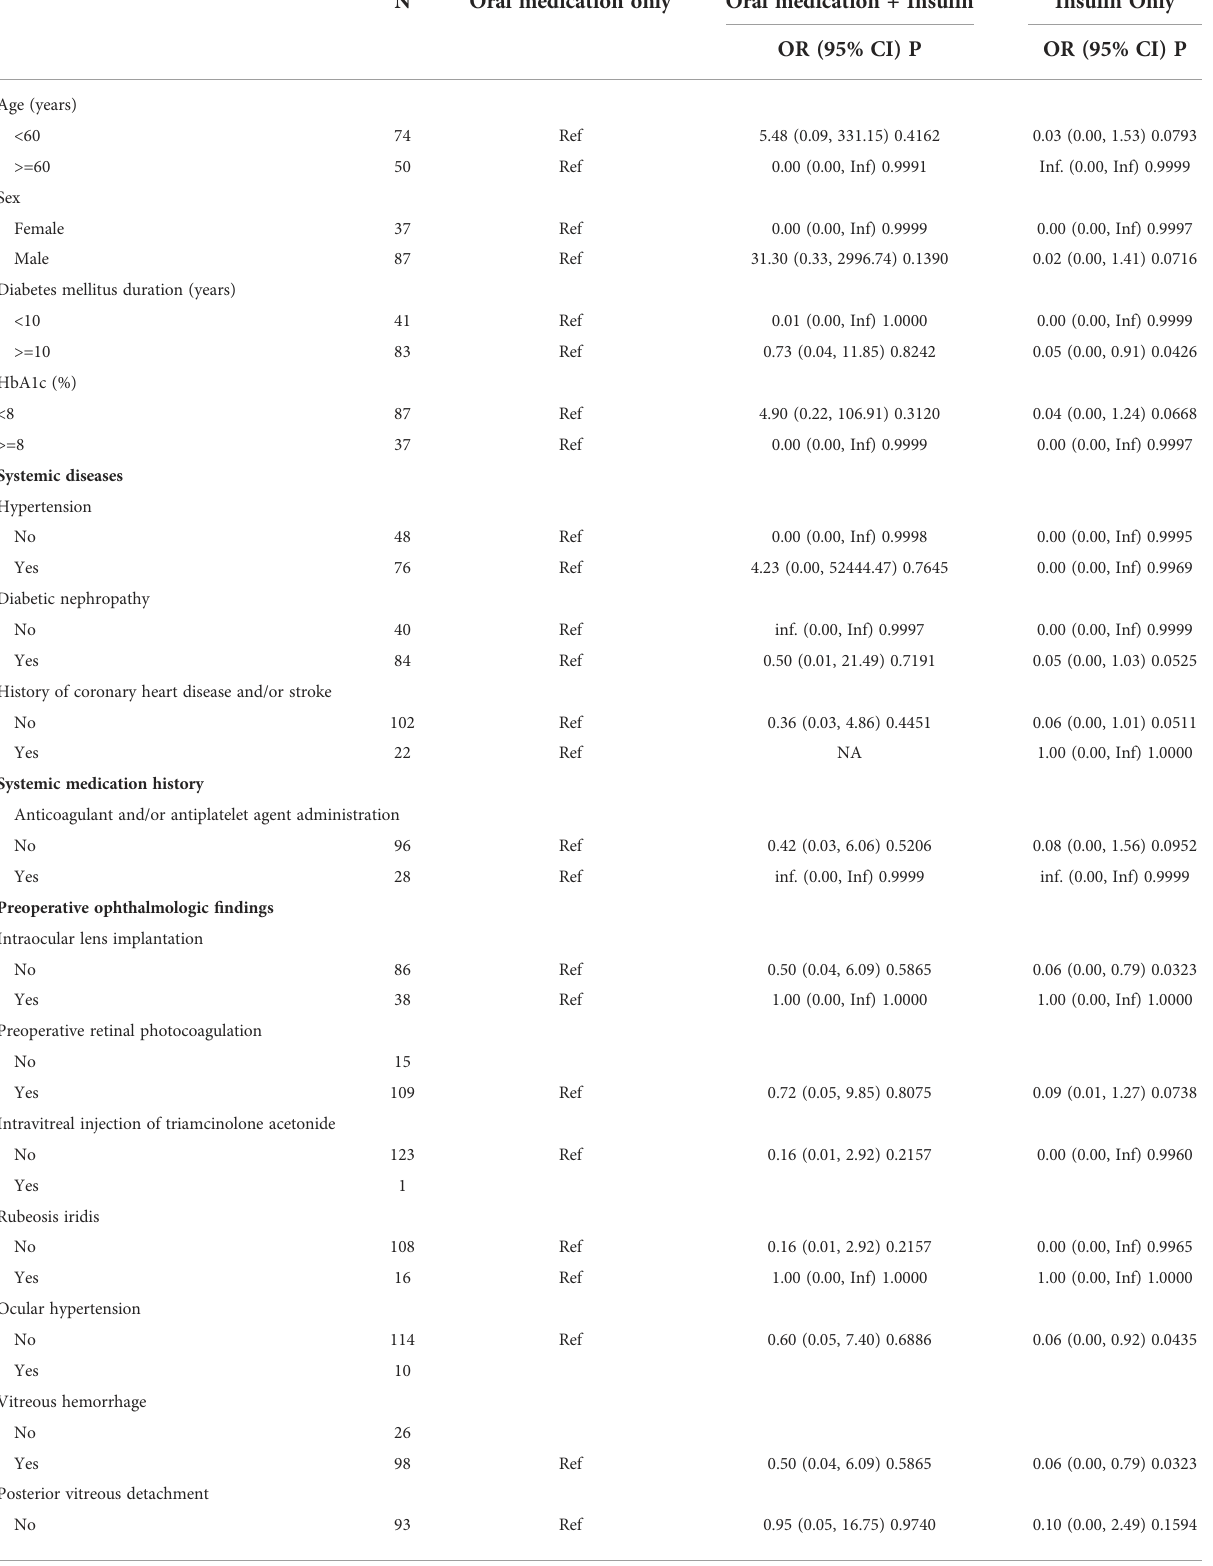
TABLE 4 The results of strati fi ed analysis between different hypoglycemic regimens and postoperative diabetic macular